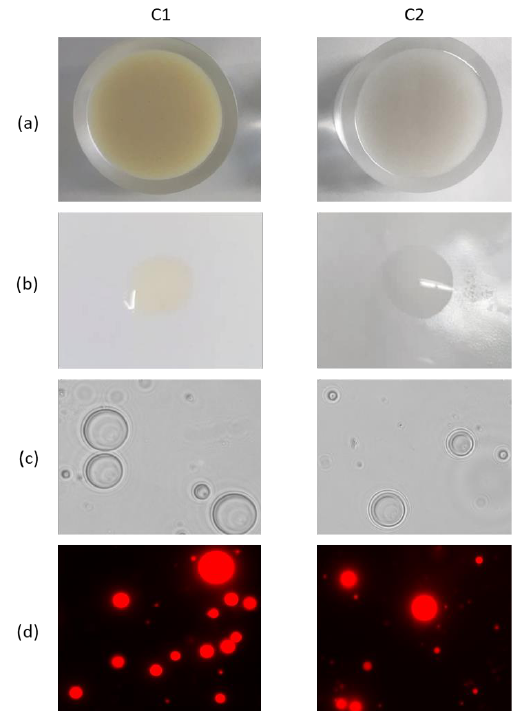
Figure 3. Formulations C1 and C2 ( a ); emulsion determination test using filter paper wetting ( b ); optical microscopic (100×) observation under contrast phase ( c ) and fluorescence after Nile blue A staining ( d ).